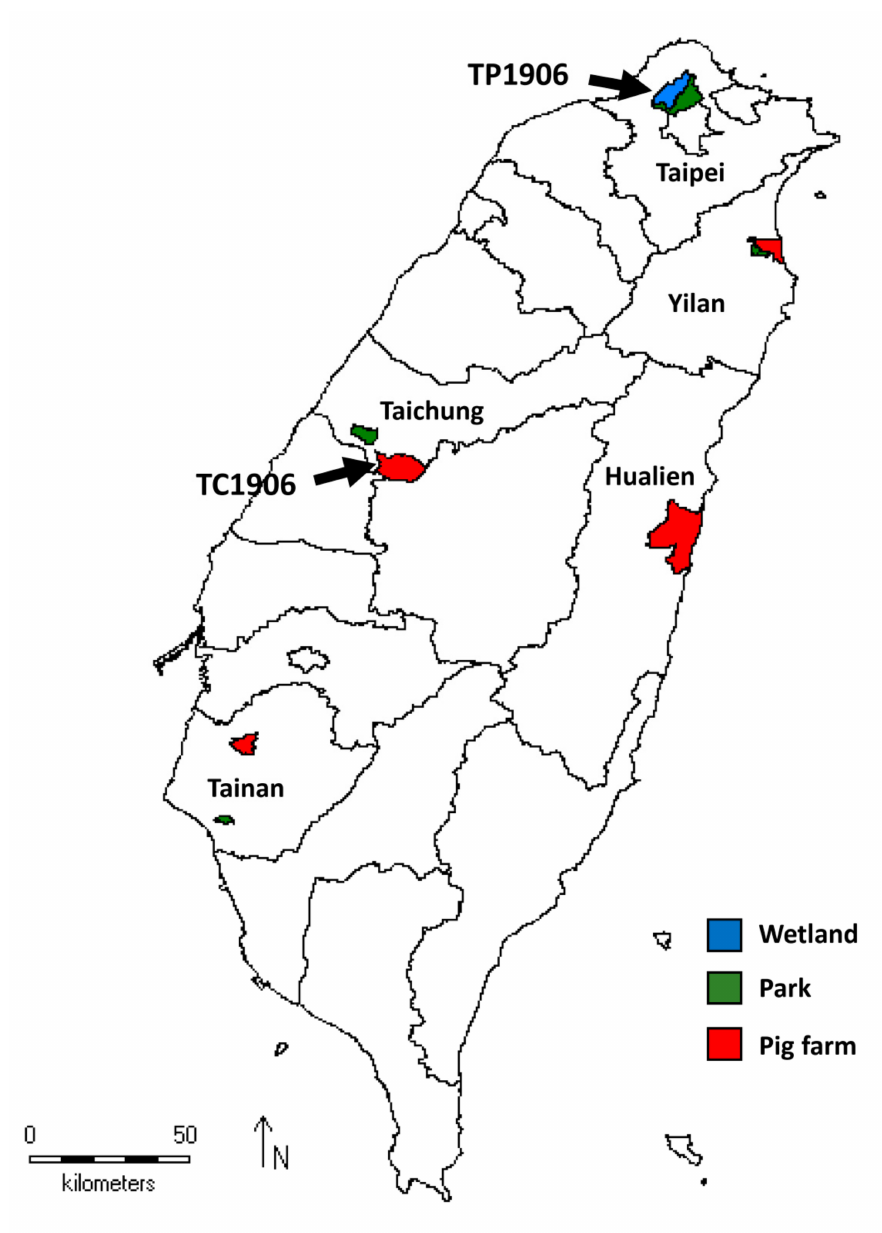
Figure 1. Map showing mosquito collection sites in Taiwan. Mosquitoes collected from wetland, parks and pig farms are indicated with blue, green and red colors, respectively. Black arrows indicate collection sites of mosquitoes infected with novel TMUV strains TP1906 and TC1906. To further study whether the novel flaviviruses detected in Cx. annulus and Cx. tritaeniorhychus mosquito pools were identical, we amplified a partial NS1 gene sequence (964 bp) by using a TMUV NS1-specific primer set (TMUV-NS1_F and TMUV-NS1_R, in Table 1) [19]. The amplified NS1 gene sequences from these two mosquito pools were 99.79% identical with two nucleotide di ff erences. The sequence obtained from the Cx. tritaeniorhynchus mosquito pool (TC1906) had a serine at amino acid position 131 of the NS1 protein (GenBank number: MN958524), while the Cx. annulus mosquito pool (TP1906) had an asparagine at position 131 (GenBank number: MN747003). The results indicated that the viruses from these two mosquito pools were very